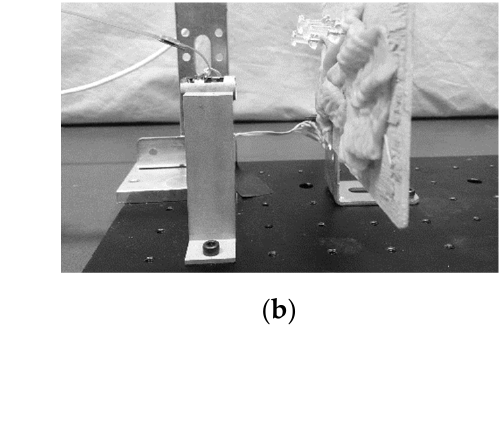
Figure 5. Shape measurement test with an in vitro porcine stomach. Experimental setup: ( a ) top view; ( b ) side view; and ( c ) substance.